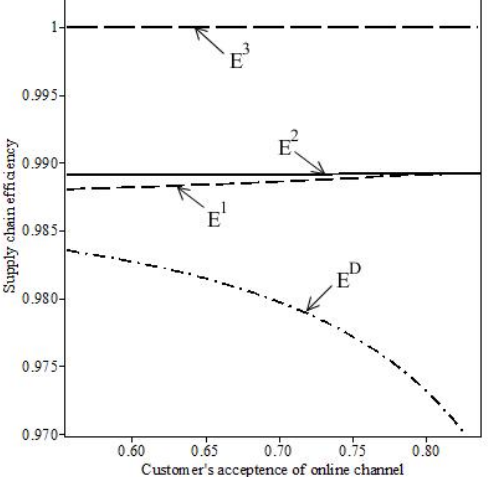
Figure 4. The impact of θ on the supply chain efficiency.